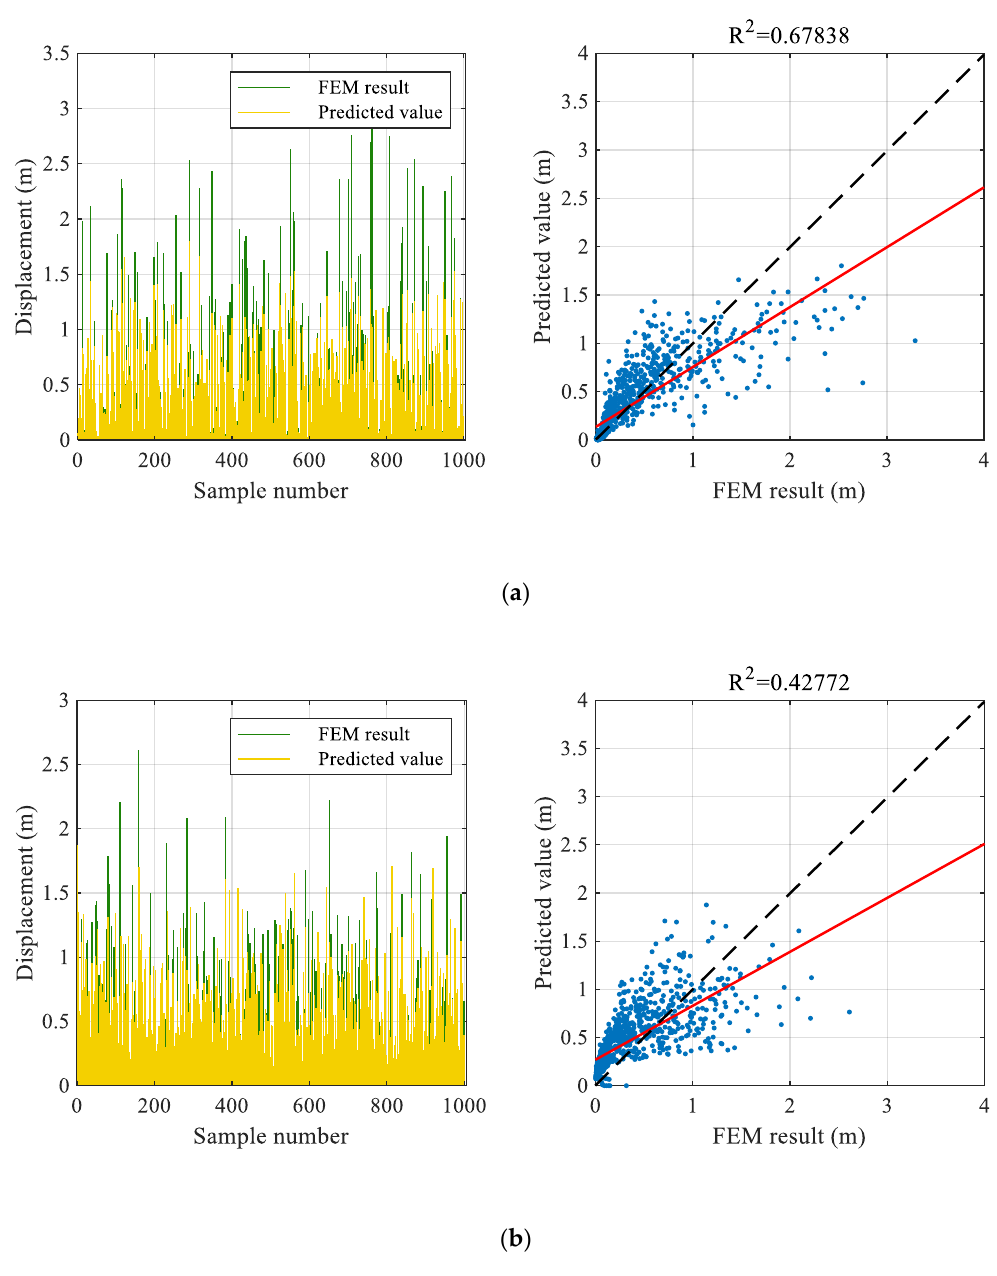
Figure 11. Test results of the BPNN model: ( a ) Test results of the BPNN based on the STFT features; ( b ) Test results of the BPNN based on FFT features.